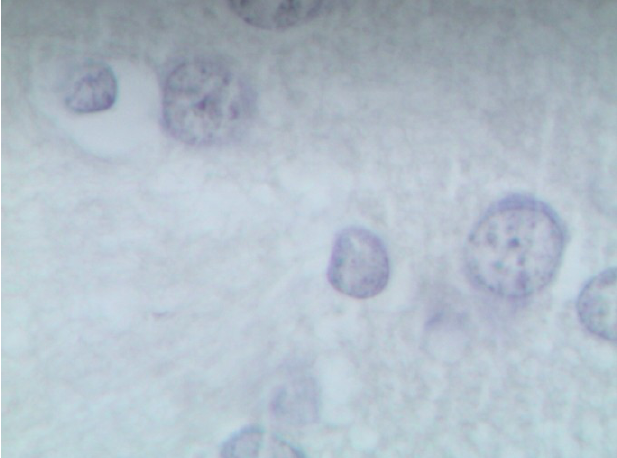
Figure 11. The brain of a rat exposed to subchronic intoxication with copper oxide nanoparticles, the nucleus caudatus area (Nissl stain, magnification ×900). A total or subtotal loss of